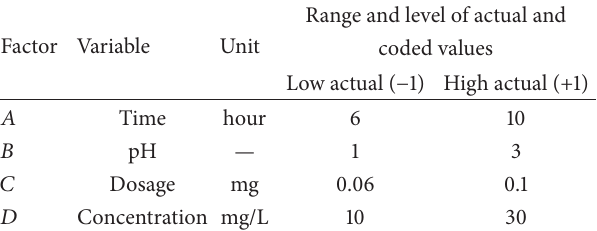
Table 1: The level and range of independent variables chosen for removal of lead from aqueous solution using tartrate-Mg-Al layered double